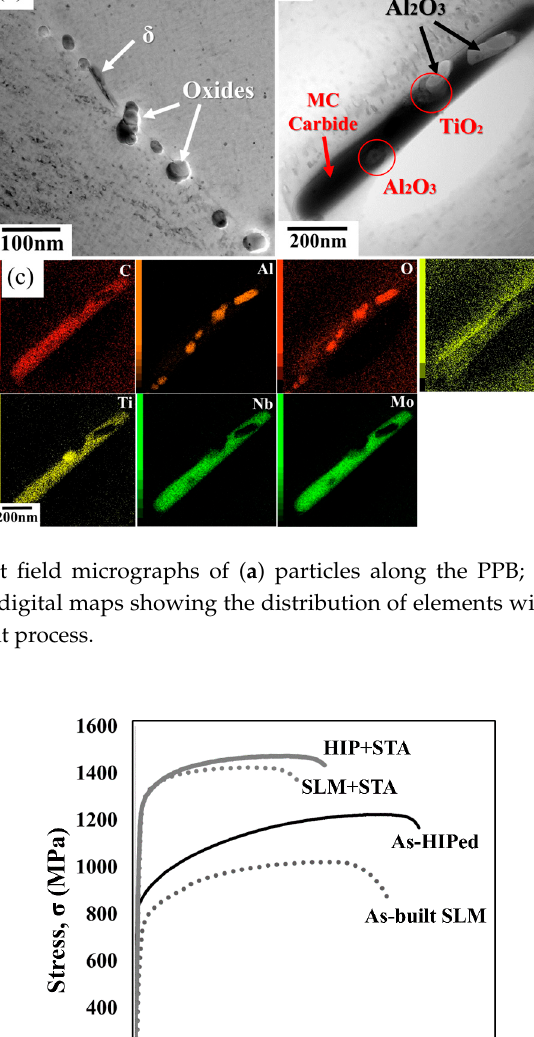
Figure 9. Engineering stress-strain curves of HIP specimen and SLM specimens at 650 °C. Table 2. Tensile properties at room temperature. σ 0.2 (MPa)